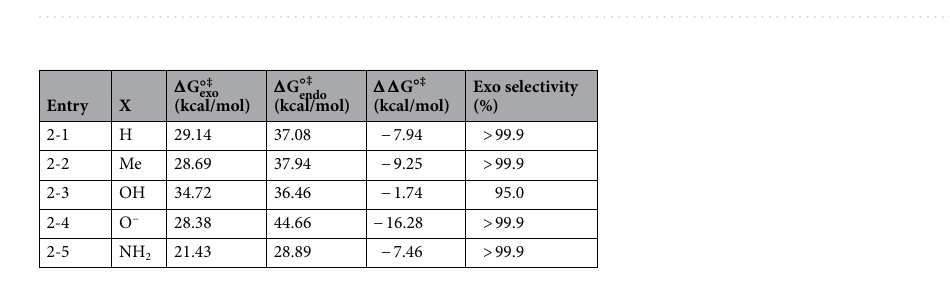
Table 5. Results of the solution-phase DFT calculations on the TSs of the three DA reactions outlined in Fig. 1.